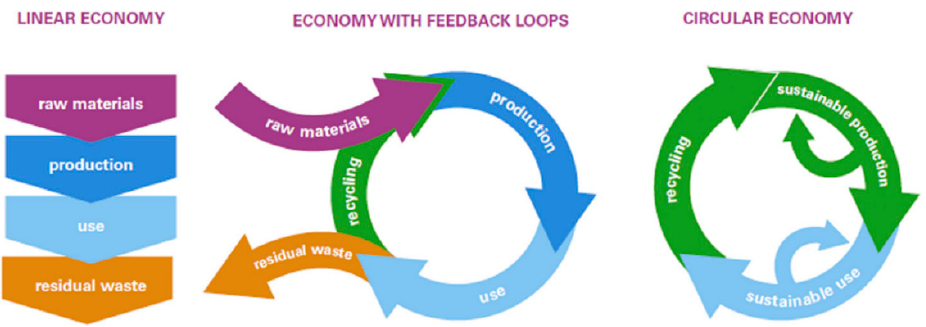
Figure 1. Life cycle stages in the linear, recycling and circular economy models [4,10].